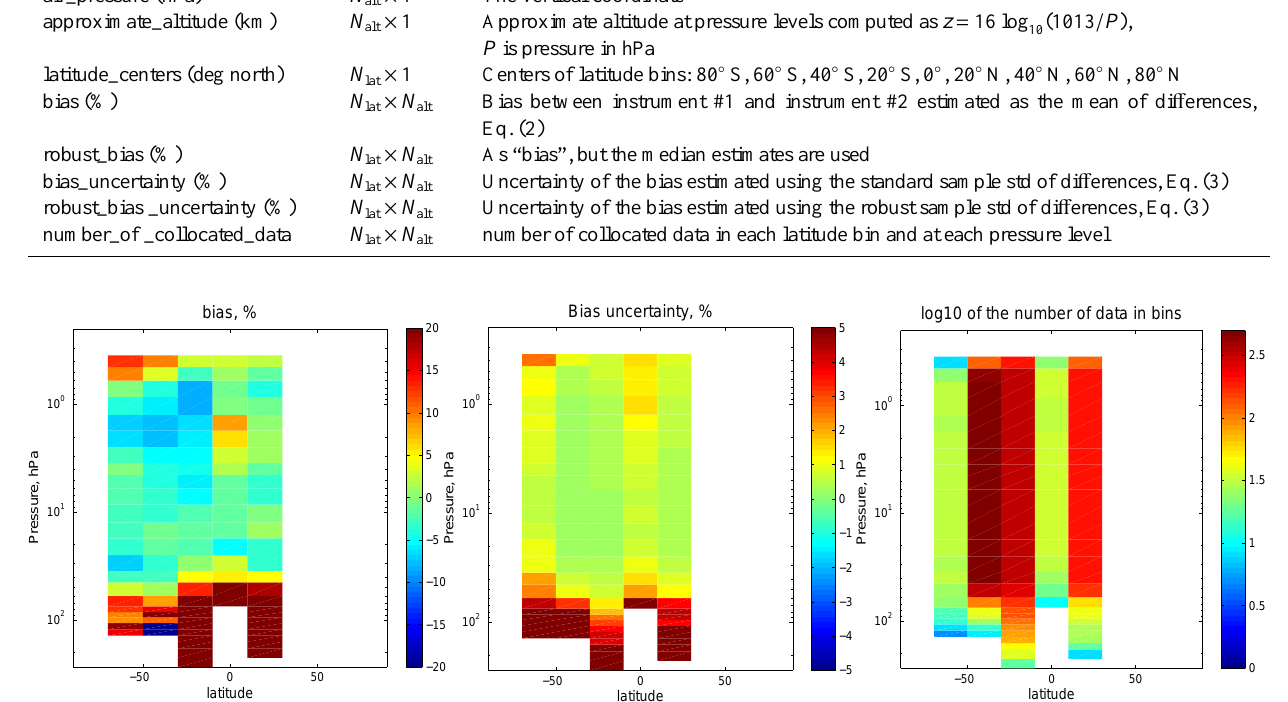
Figure 4. A visualization example of bias-related parameters from bias tables, for GOMOS versus OSIRIS in January 2008.